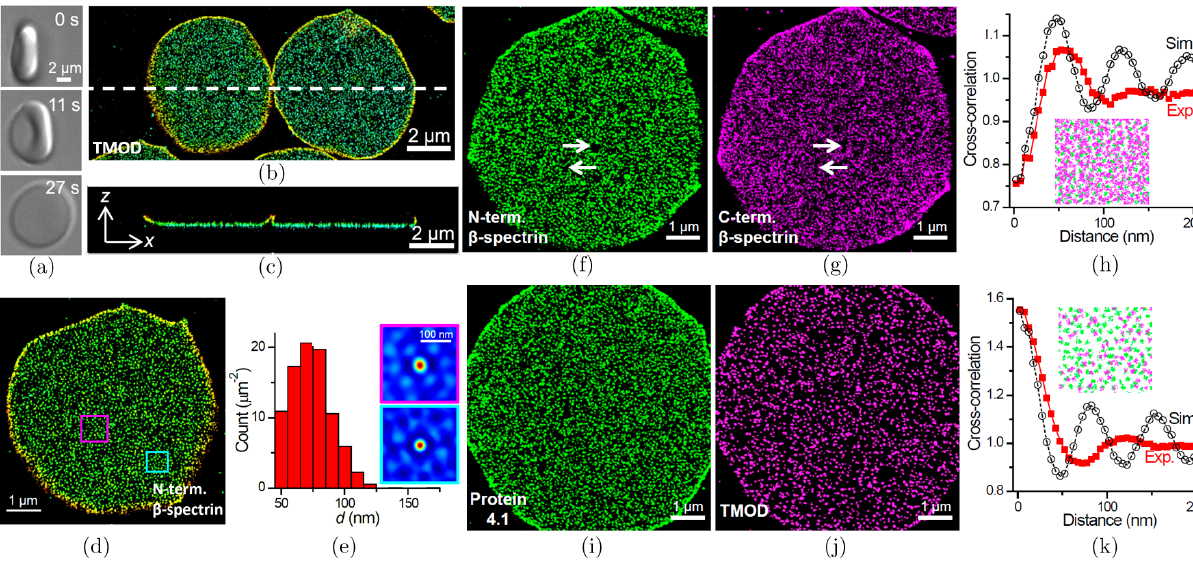
Fig. 7. The native ultrastructure of the erythrocyte membrane-skeleton revealed by super resolution °uorescence microscopy. (a) Di®erential interference contrast microscopy montages recording the bottom-°attening process of a live erythrocyte. (b) 3D- STORM picture of TMOD in bottom-°attened erythrocytes. (c) Virtual cross-section of the 3D-STORM image in the xz plane along the white dash line in (b). (d) 3D-STORM picture of the N terminus of (cid:1) -spectrin. (e) Analysis of distances between nearest neighbors of (cid:1) -spectrin clusters in (d). Insets: two-dimensional autocorrelation for the cyan- and magenta-boxed regions in (d). (f), (g), (i) and (j) STORM images of the N terminus (f), C terminus (g) of (cid:1) -spectrin, protein 4.1 (i) and TMOD (j), respectively. (h) and (k) Two-dimensional pairwise cross-correlation calculation between the two color channels at di®erent intermolecular distances based on the experimental (red) and simulated (black) data. Figures are adapted with permission from Ref.